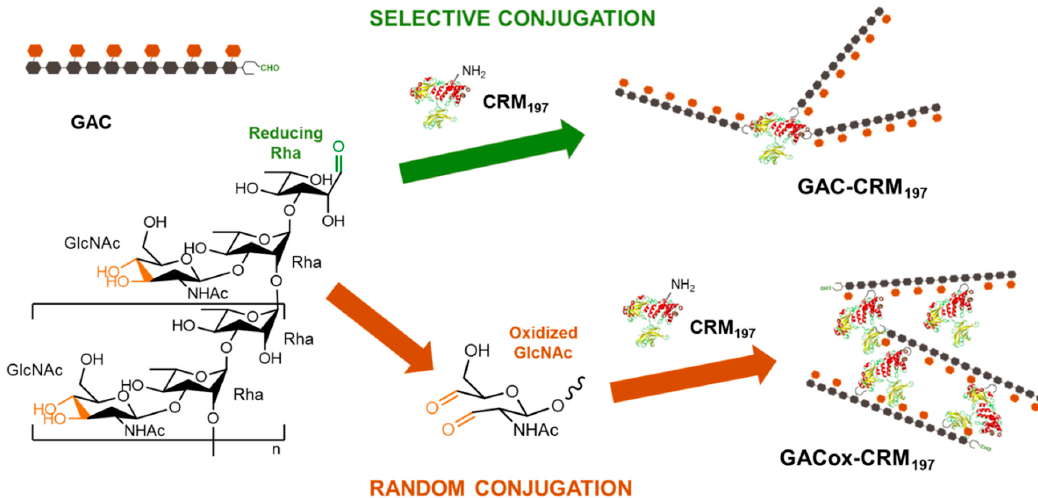
Figure 1. Conjugation strategies for producing Group A Streptococcus (GAS) conjugates: selective direct reductive amination between the aldehyde group at the reducing residue of GAC and lysines of the carrier protein (green approach) [12] and reductive amination between the aldehyde groups randomly generated through oxidization of GAC and lysines of the carrier protein (orange approach).